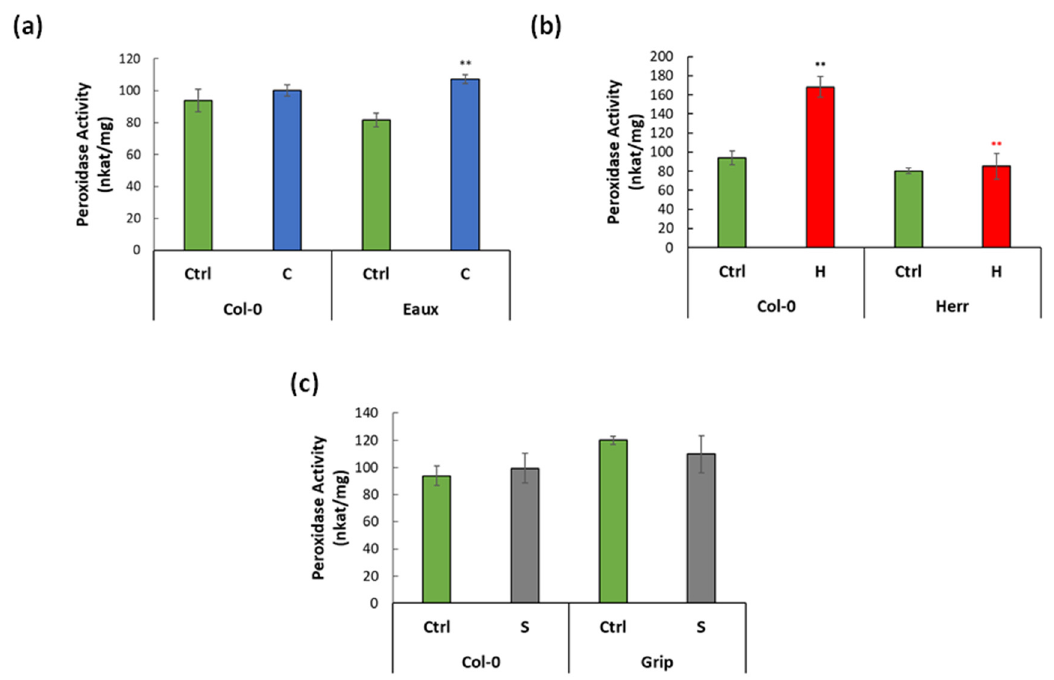
Figure 6. Bar plots displaying CIII Prx activity (nkat/mg of proteins) in ( a ) Col-0 and Eaux under ctrl and cold conditions, ( b ) in Col-0 and Herr under ctrl and hot conditions, and ( c ) in Col-0 and Grip under ctrl and saline conditions. (**) p -value < 0.001 of the Student’s t -test of the pairwise comparisons between two treatments in each population (black) or between Col-0 and the Pyrenean population at each treatment (colored). The error bars correspond to the standard error of means (SEM).